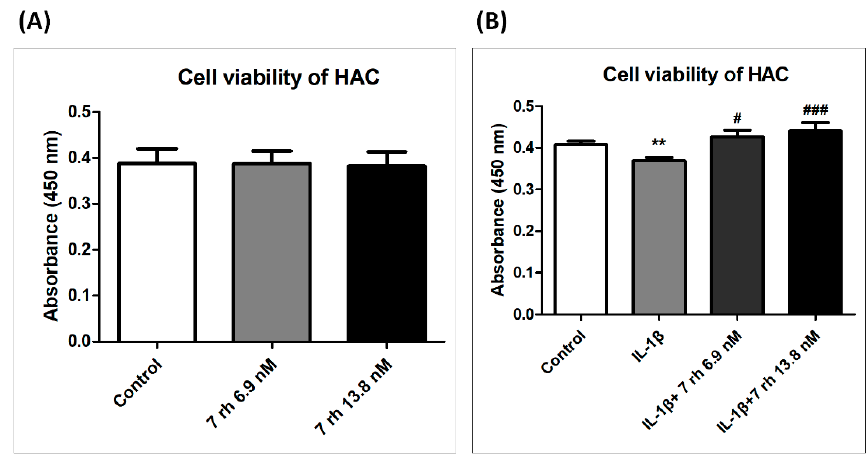
Figure 1. The cytotoxic effects of 7 rh on human articular chondrocytes (HAC). ( A ) The cell viability of HAC that was treated with 6.9 nM and 13.8 nM of 7 rh for 48 h was detected by CCK8 assay. ( B ) The chondrocytes were co-cultured with IL-1 β and 7 rh (6.8 nM and 13.9 nM) for 48 h. The cell viability was measured by CCK8 assay. All experiments were performed in quadruplicate and repeated three times with similar results. (** p < 0.01 versus the control group; # p < 0.05, and ### p < 0.001 versus the IL-1 β -treated group).